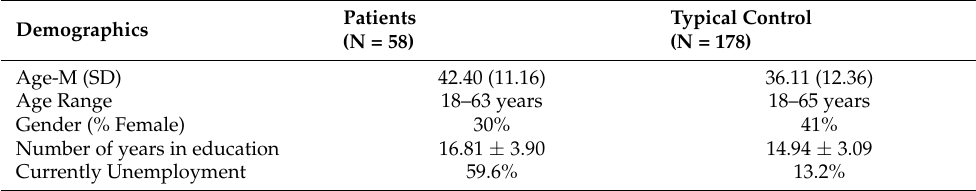
Table 1. Patient and control group